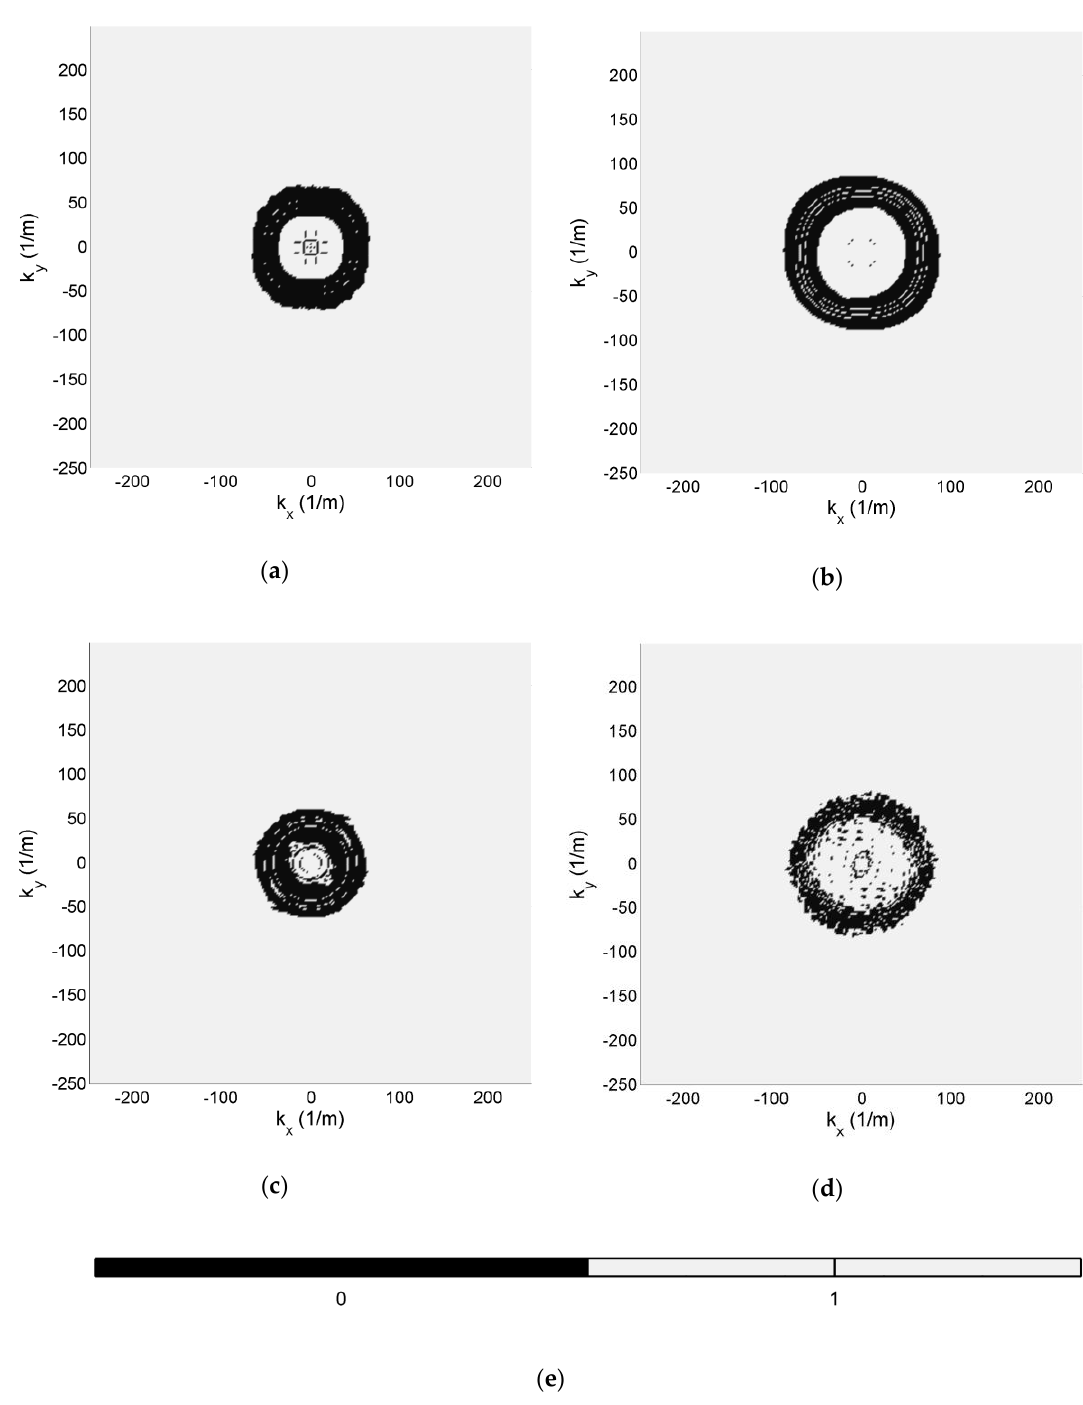
Figure 10. Filter masks for: ( a ) CFRP; ( b ) GFRP; ( c ); SFRP ( d ); HCSP specimen; ( e ) Color scale.